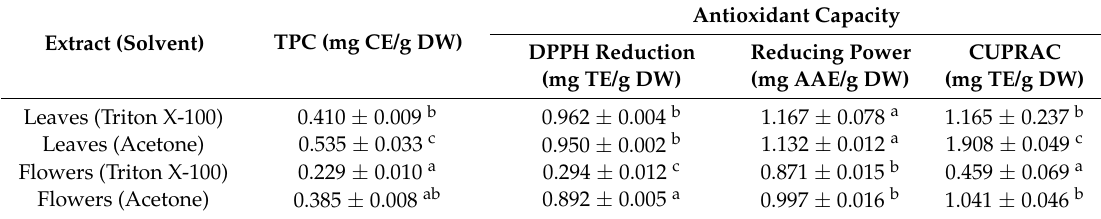
Table 1. Total phenolic content and antioxidant capacity of Taraxacum officinale extracts.